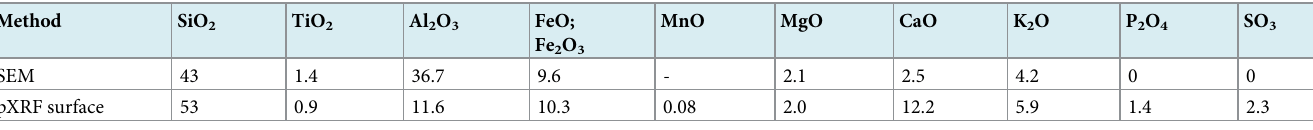
Mean values in wt%, normalized, MnO is not measured with SEM, FeO is due to SEM, Fe2O2 by pXRF (for discussion see